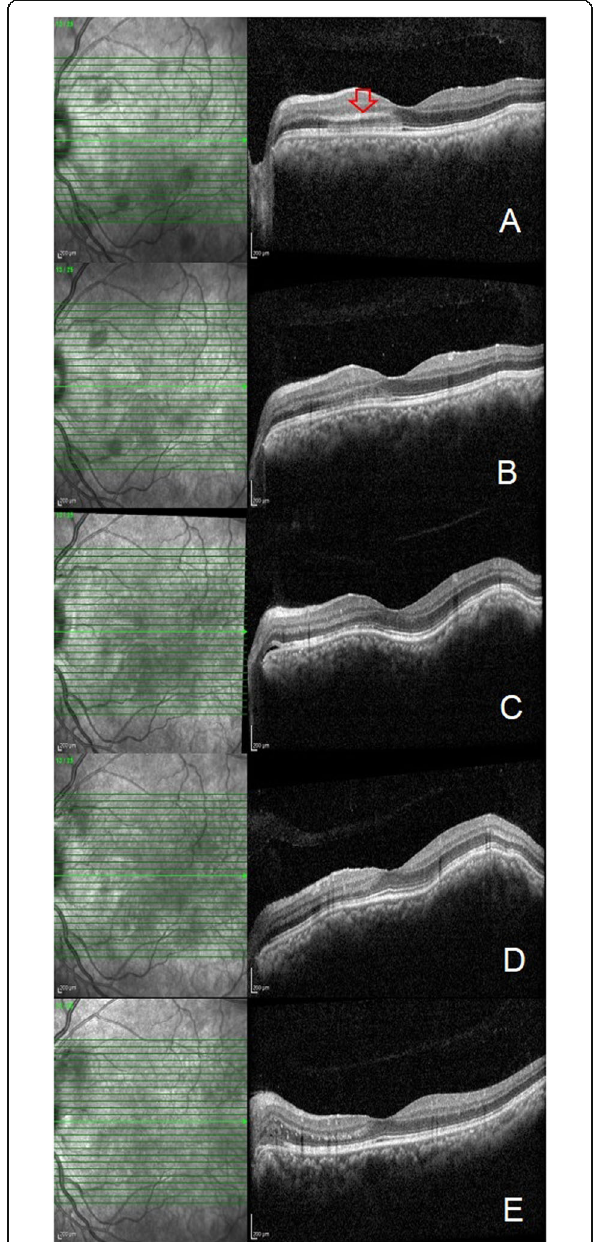
Fig. 2 Sequential OCT scans of the left eye at presentation, 4-day, 7- day, 14-day, and 6-month visits. a Horizontal raster OCT scan at presentation showing a hyperreflective plaque at the outer side of the outer plexiform layer with hyperreflectivity of the outer nuclear layer and disruption of ellipsoid zone involving the nasal macular quadrant suggestive of type 2 AMN (red arrow). b Horizontal raster OCT scan at 4 days showing reduced hyperreflectivity and resolution of the AMN lesion. c OCT scan at 7 days showing RPE elevation by the underlying choroidal lesion (white arrow). d OCT scan at 14 days post presentation showing progressive increasing RPE elevation due to the choroidal granuloma (white arrow). e OCT scan at 6-month post ATT showing resolution of the choroidal granuloma (white